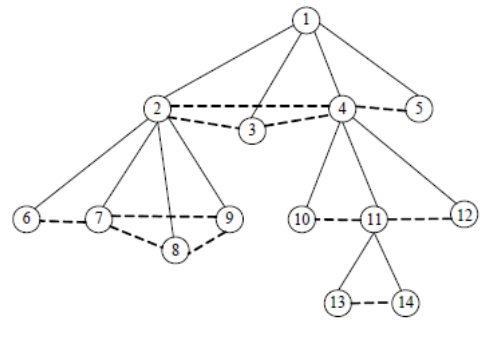
Fig.4. Hierarchical cluster